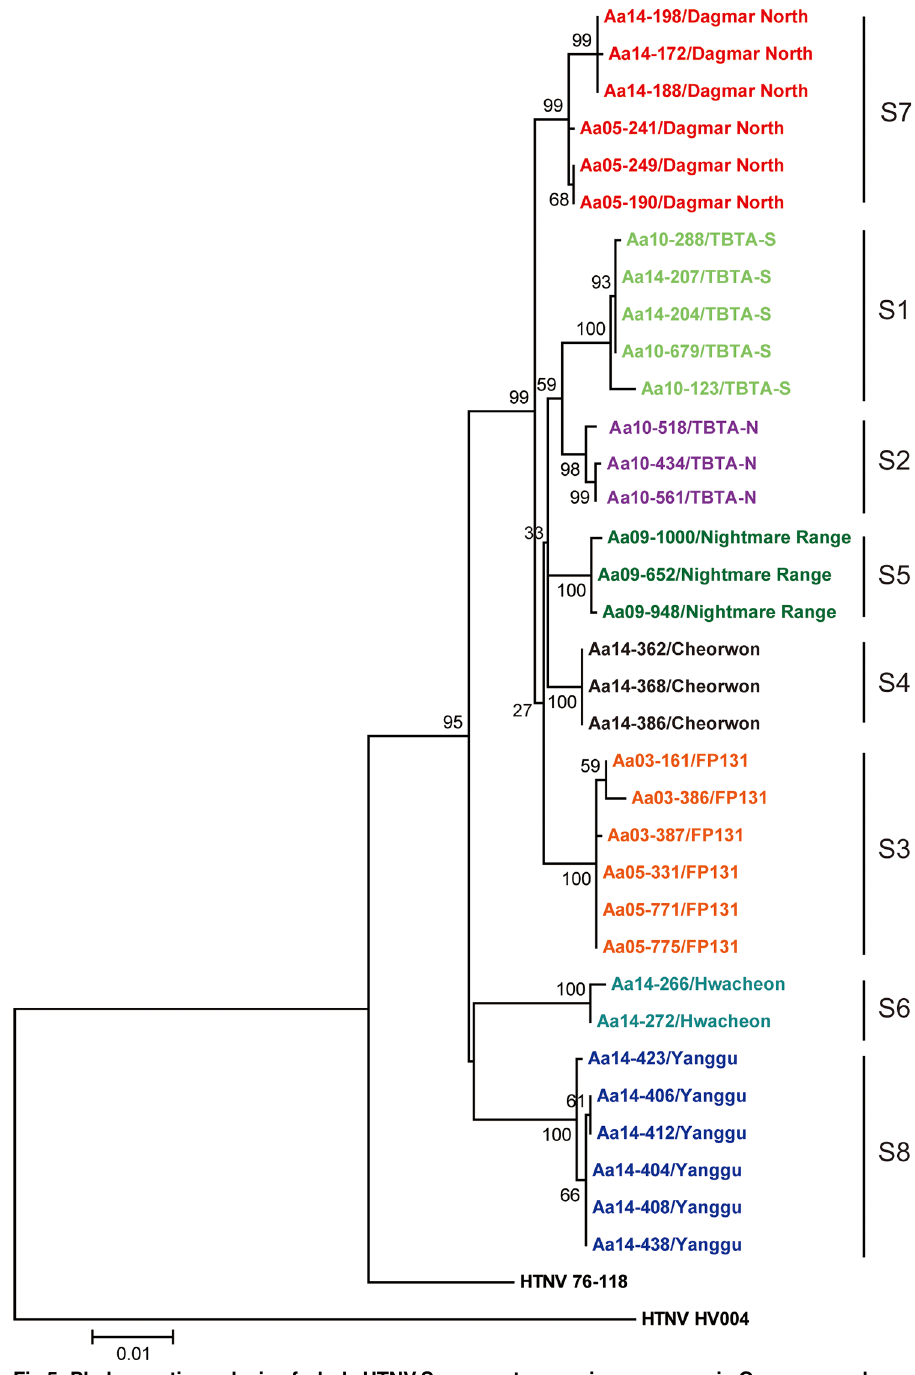
Fig 5. Phylogenetic analysis of whole HTNV S segment genomic sequences in Gangwon and Gyeonggi provinces. The full-length sequences of the HTNV S segment were obtained from lung tissues of A . agrarius in Gangwon and Gyeonggi provinces. A phylogenetic tree was generated by the ML method. Topologies were evaluated by bootstrap analyses of 1000 iterations. The T92+G model of evolution was used, based on an alignment of the nucleotide sequence of the S segment, including strains HTN 76 – 118 (M14626) and HTN HV004